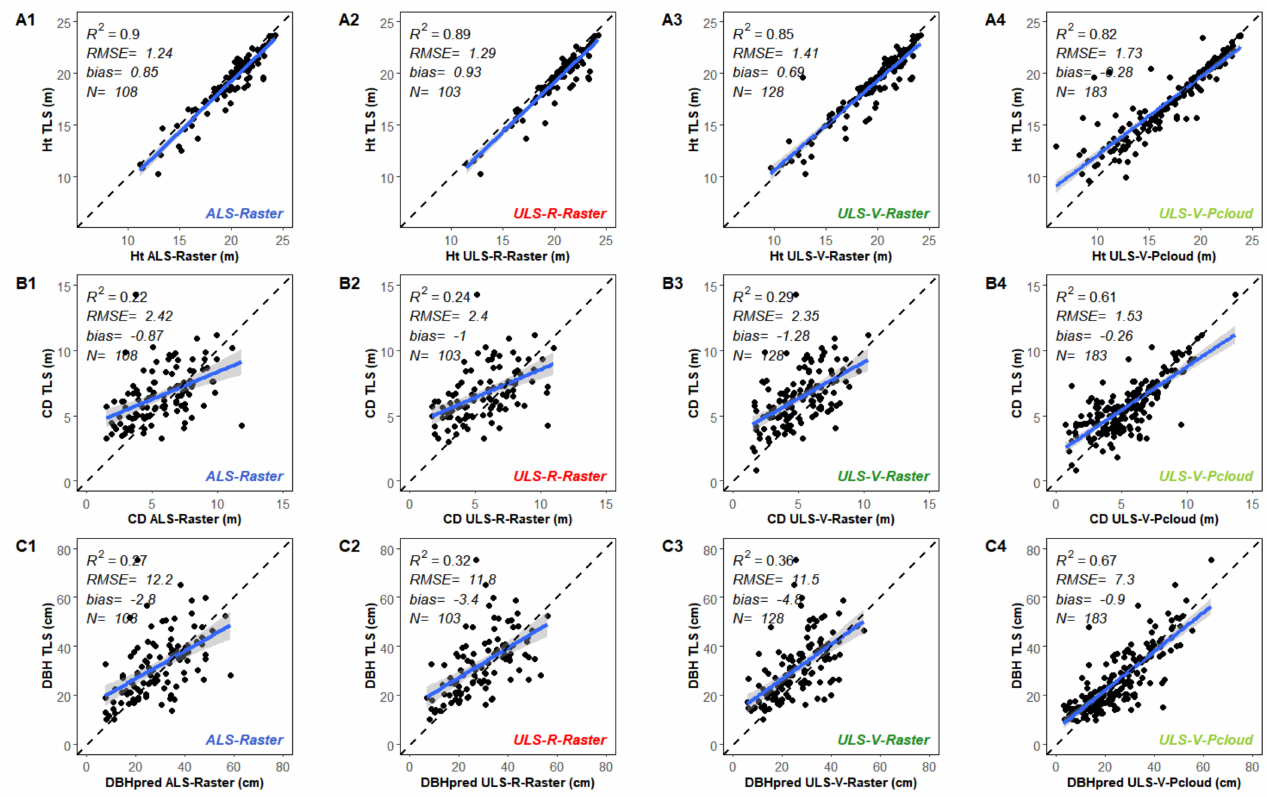
Figure 13. Comparison of ( A ) tree height, ( B ) tree crown diameter (CD), and ( C ) DBH predicted (DBH pred ), which were estimated from (1) ALS-Raster, (2) ULS-R-Raster, (3) ULS-V-Raster, and (4) ULS-V-Pcloud, against their paired TLS reference (cid:16) (cid:17) trees Ntrees paired . The gray zone is the 95% confidence band for